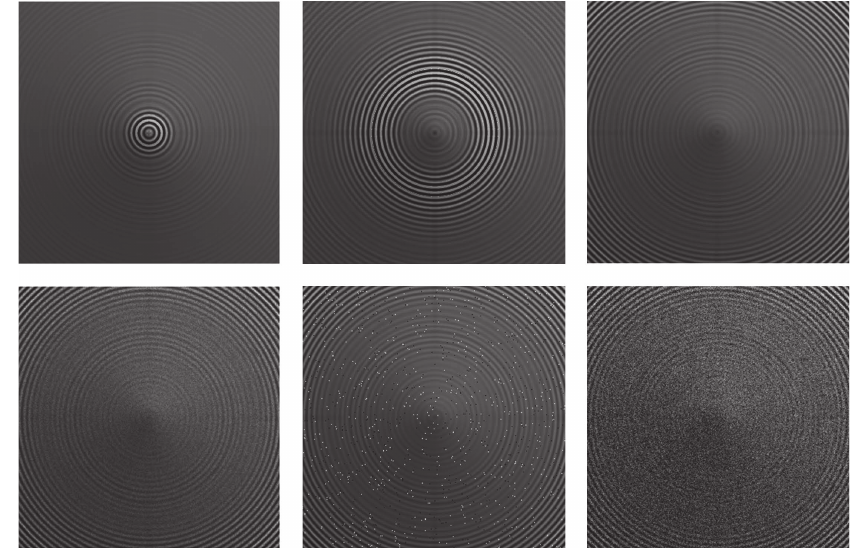
Figure 6. Sample images from the sequence of a simulated cone: noise-free (first row), in the presence of noise (second row), Gaussian noise with zero mean and a variance of 0.01 (first column), salt and pepper noise with a variance of 0.01 (second column) and speckle noise with a variance of 0.01 (last column).